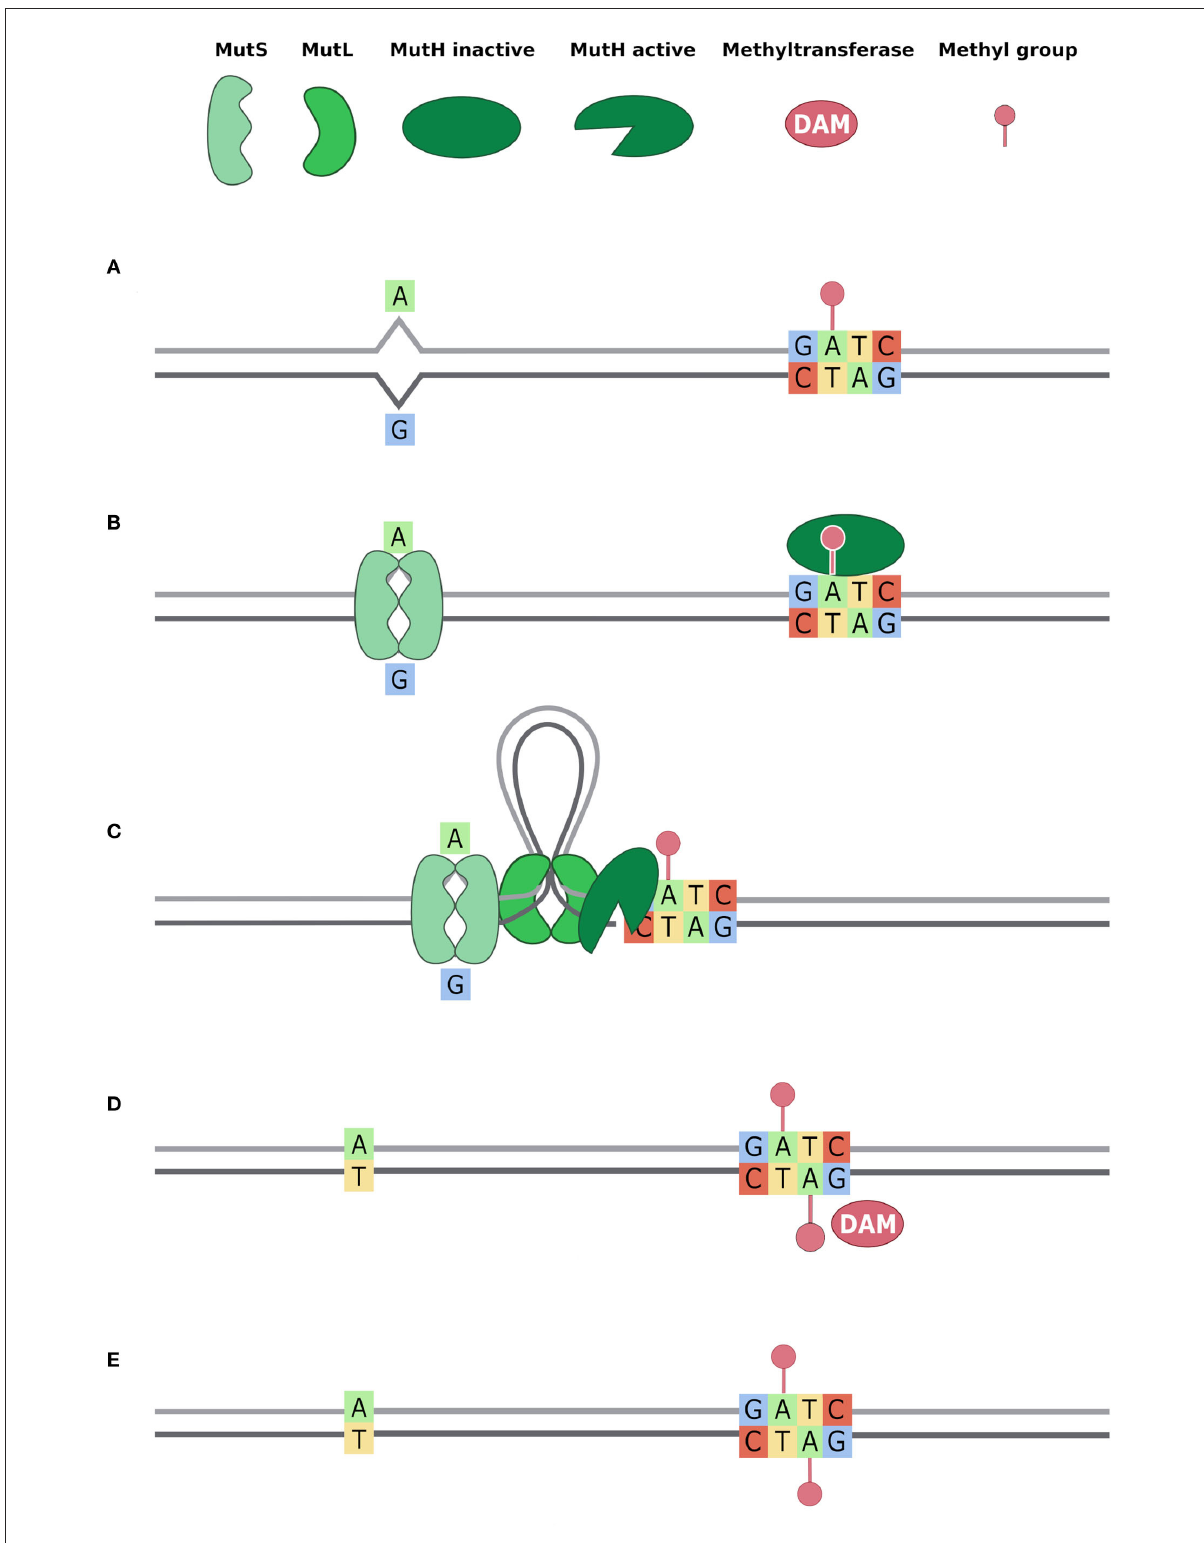
FIGURE5 Methyl Mismatch Repair system (MMR) (also known as MutSLH). Dam methyltransferase methylates the GATC motifs right after the action of DNA polymerase and DNA repair systems (Acharya et al., 2003; Li, 2008; Sandoval-Motta and Aldana, 2016). Thus, when DNA repair systems